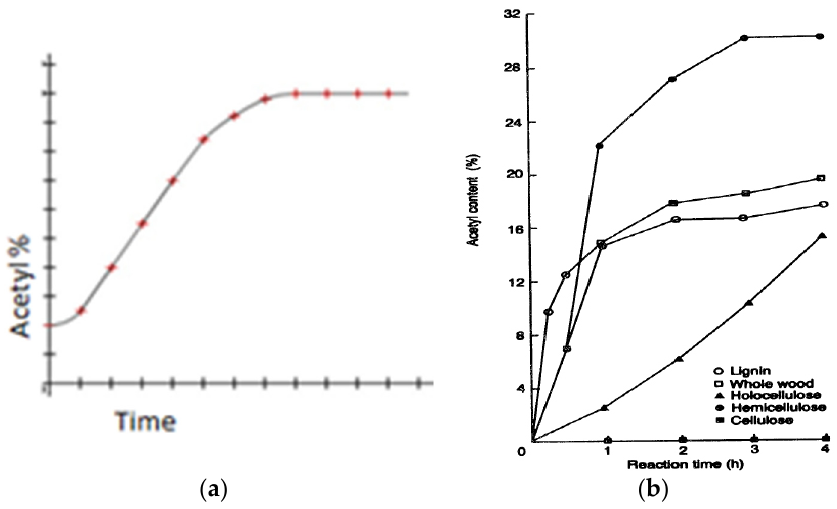
Figure 10. ( a ) Reaction of acetic anhydride with wood; ( b ) Reaction of acetic anhydride with isolated cell wall polymers [1,9].